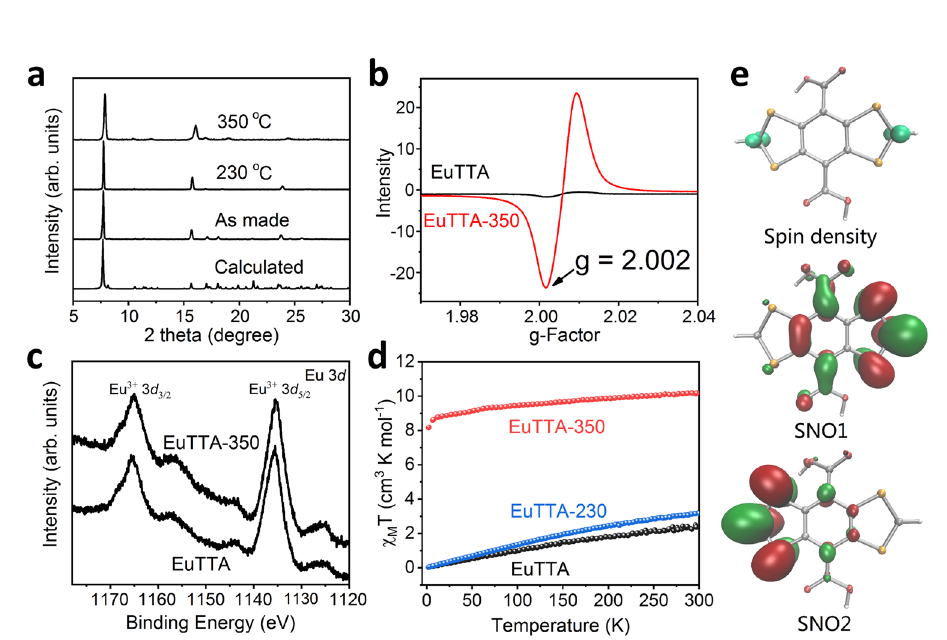
Fig. 3 | Characterization of the crystalline solids of EuTTA and its radical- containingderivatives.a PowderX-raydiffractionpatternsofEuTTA,EuTTA-230, and EuTTA-350. b Solid-state EPR spectraof EuTTAand EuTTA-350at300K. c The XPS spectra of Eu 3 d of EuTTA and EuTTA-350. d Plots of χ M T versus T for EuTTA,